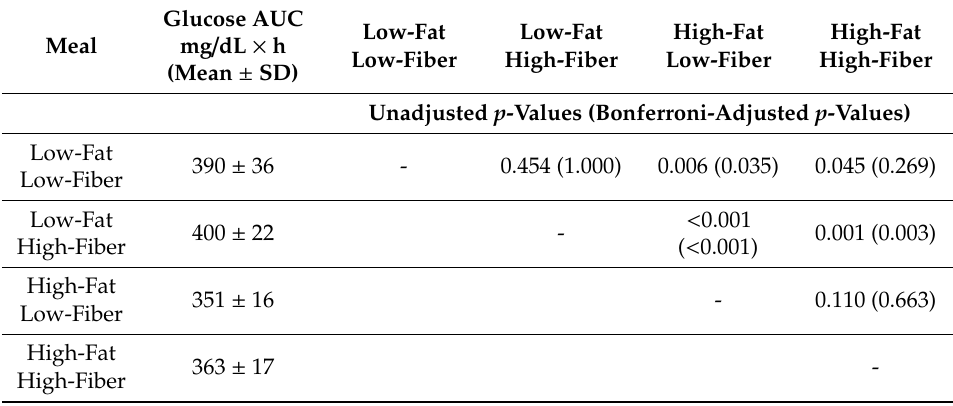
Figure 2. Glycemic response as area under curve (AUC) over 4 h in response to the four meals. Boxes for each meal represent the interquartile range. Minimum and maximum values are indicated at the tips of each vertical line. The median for each meal is depicted by the horizontal line within each box. See Table 4 for statistical comparisons between meals. Table 4. Blood glucose area under curve (AUC): comparisons between meals.